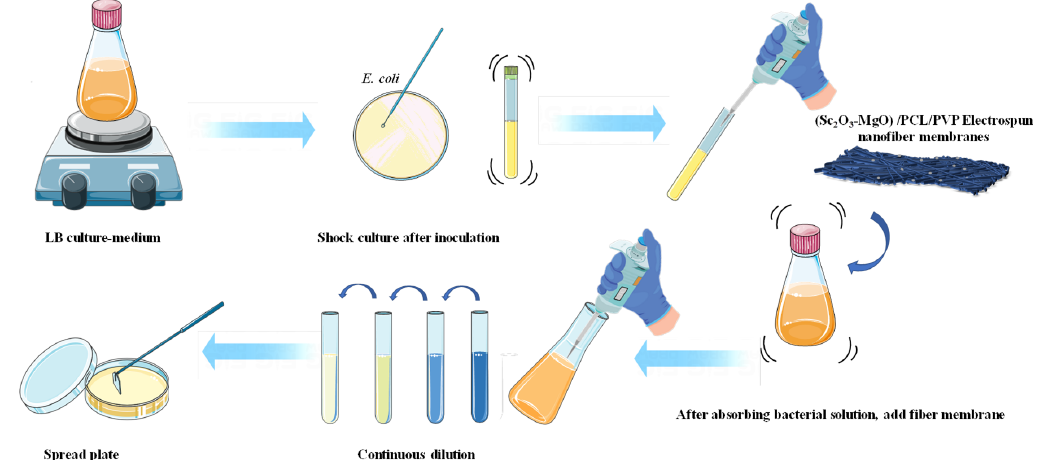
Figure 7. Operation steps of antibacterial experiment.